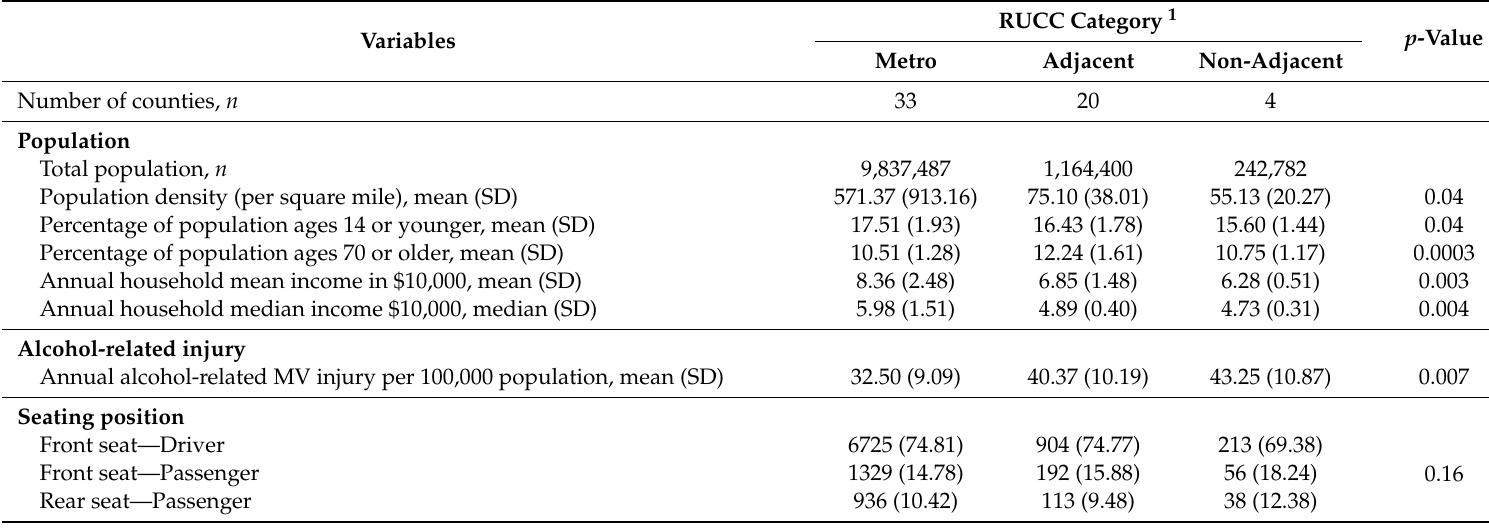
Table 2. County characteristics by Rural–Urban Continuum Codes